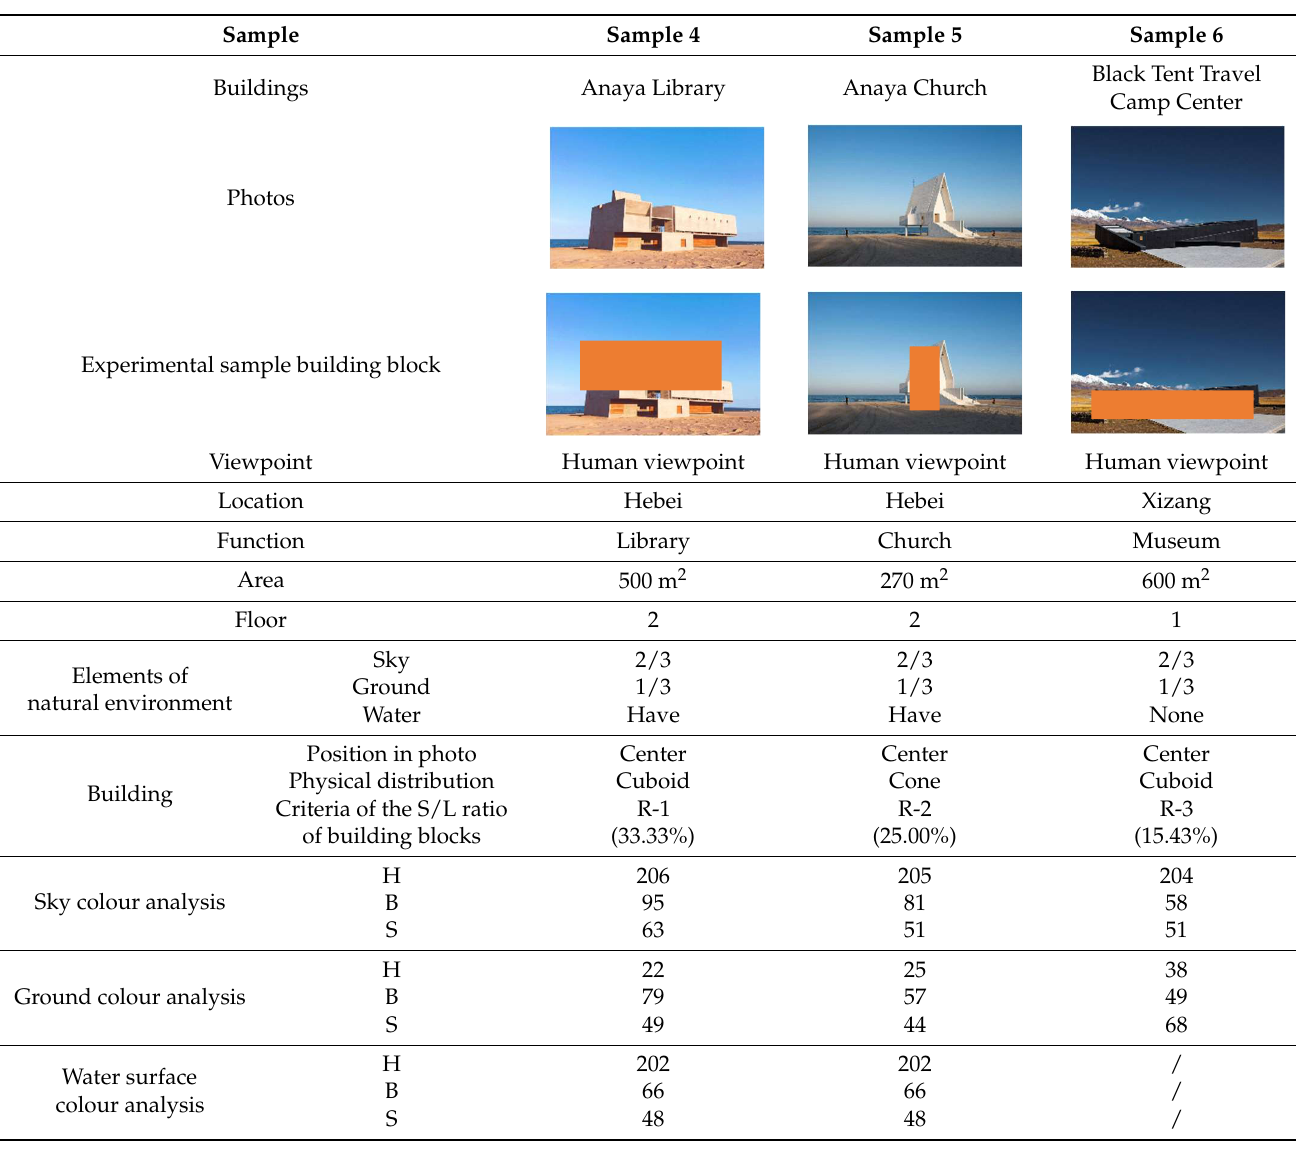
Table 7. Picture analysis of the second group of experimental subjects.